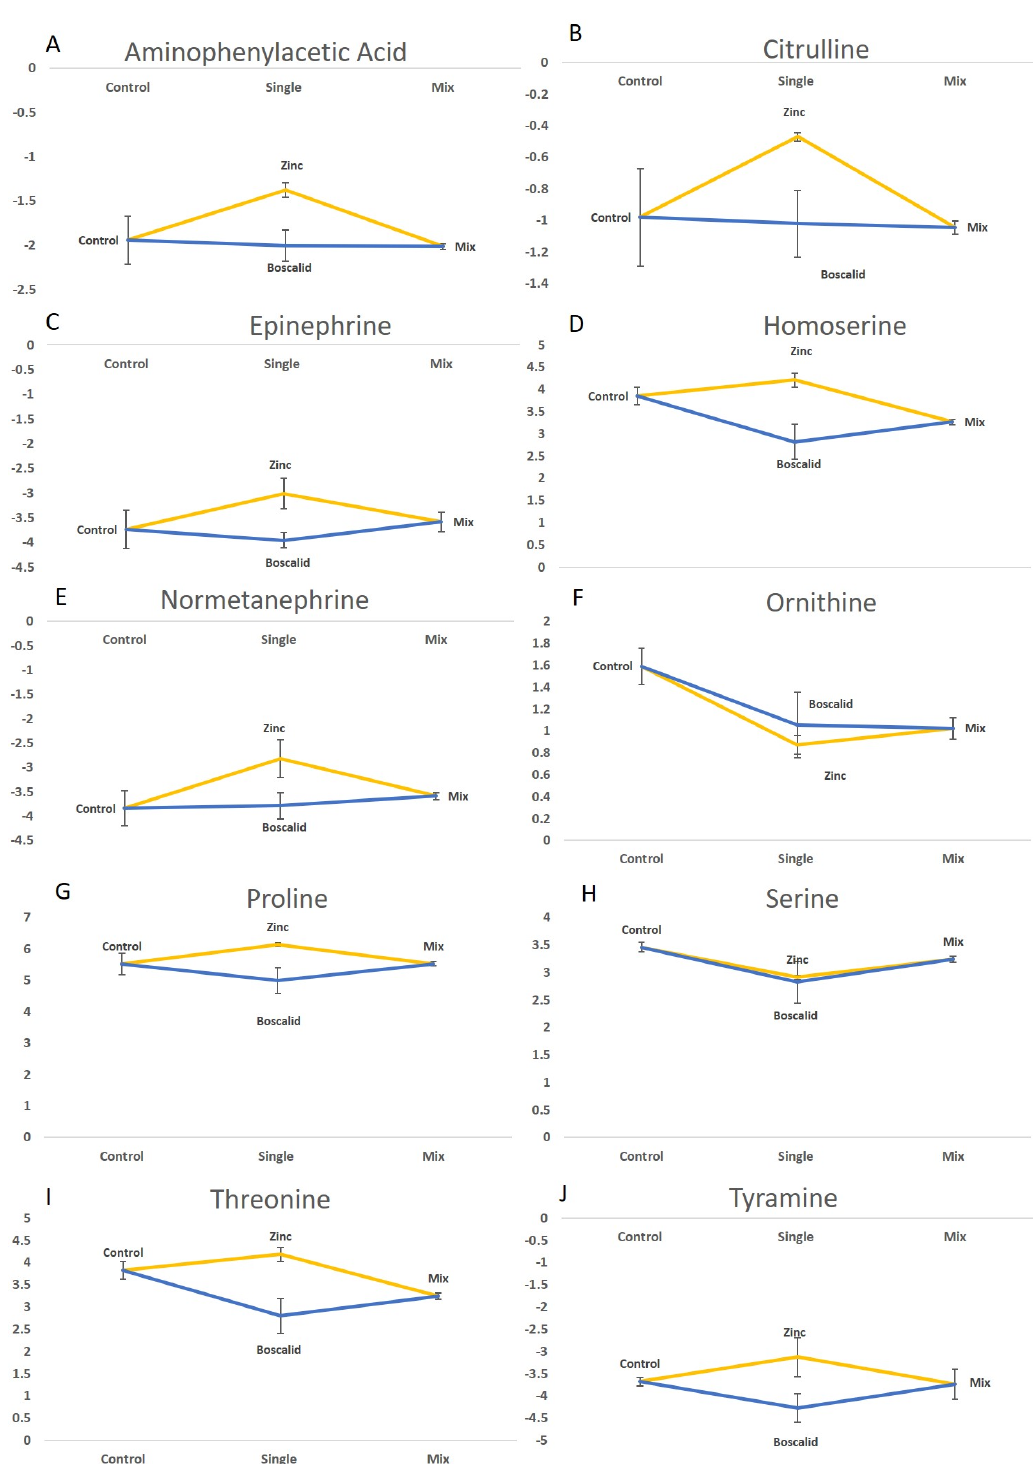
Figure 4. Line graphs of metabolites which significantly changed in abundance ( p < 0.05) following whole annelid ( S. aequisetis ) single exposure to zinc, boscalid and to their mixture using LC-MS data: ( A ) Aminophenylactic acid; ( B ) Citrulline; ( C ) Epinephrine; ( D ) Homoserine; ( E ) Normetanephrine; ( F ) Ornithine; ( G ) Proline; ( H ) Serine; ( I ) Threonine; and ( J ) Tyramine. Y axis shows the peak area for each metabolite from the LC-MS